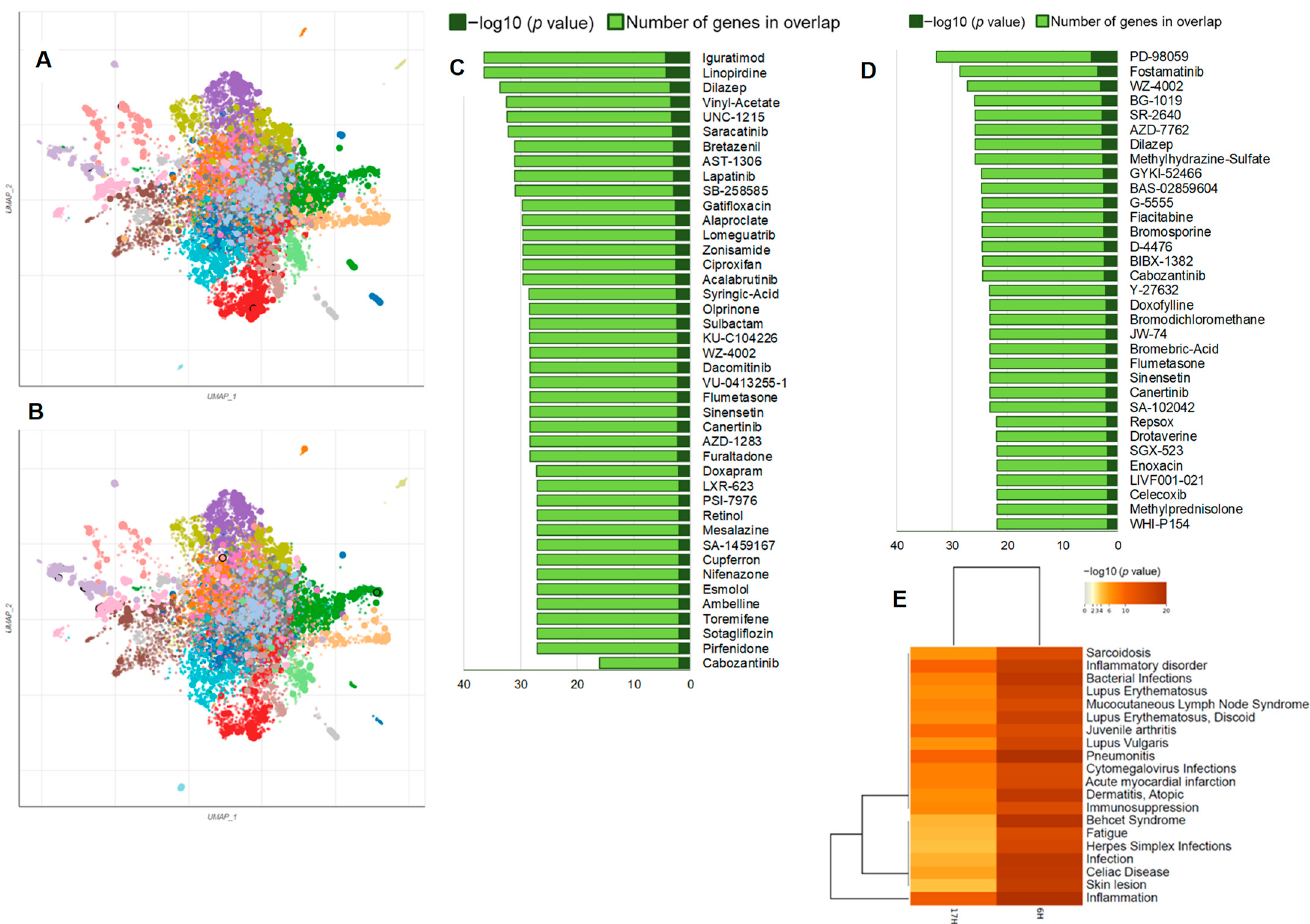
Figure 10. Chemical Perturbations and disease–gene association enrichment analysis by downregulated DEGs in BTEE-treated RAW264 cells from LINCS L1000 library and DisGeNET database. Scatterplots of all terms in the LINCS L1000 chemical perturbation consensus signature gene set library; ( A ) 6-h condition, ( B ) 17-h condition. Each point represents a term in the library. Term frequency–inverse document frequency (TF–IDF) values were computed for the gene set corresponding to each term, and the UMAP dimensionality reduction approach was applied to the resulting values. The terms are plo tt ed based on the fi rst two UMAP dimensions. Generally, terms with more similar gene sets are positioned closer together. Terms are colored by automatically identi fi ed clusters computed with the Leiden algorithm applied to the TF–IDF values. The darker and larger the point, the more signi fi cantly enriched the term. From the sca tt er plots, drugs or chemicals that downregulate Axl expression are identi fi ed and plo tt ed in the bar graphs; ( C ) 6-h condition, ( D ) 17-h condition. ( E ) Heatmap shows enrichment analysis of disease–gene association in DisGeNET.